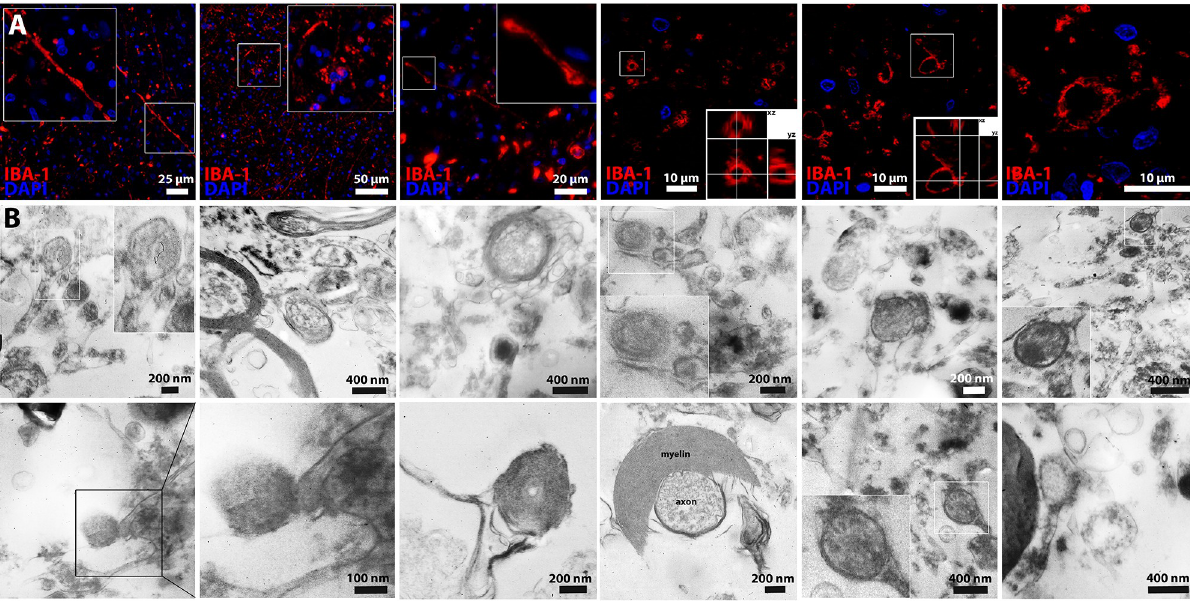
Fig 6. Migrasome formation in human stroke specimens. (A) Iba1 (microglia/macrophage)-stainings showed cells with unequivocal morphological features of migrasomes in postmortem brain tissue of patients who died within a few days after having a stroke ( < 7 days). (B) Electron microscopy of human stroke specimen also showed similar characteristics of the migrasome on the ultrastructural level within infarcted tissue.